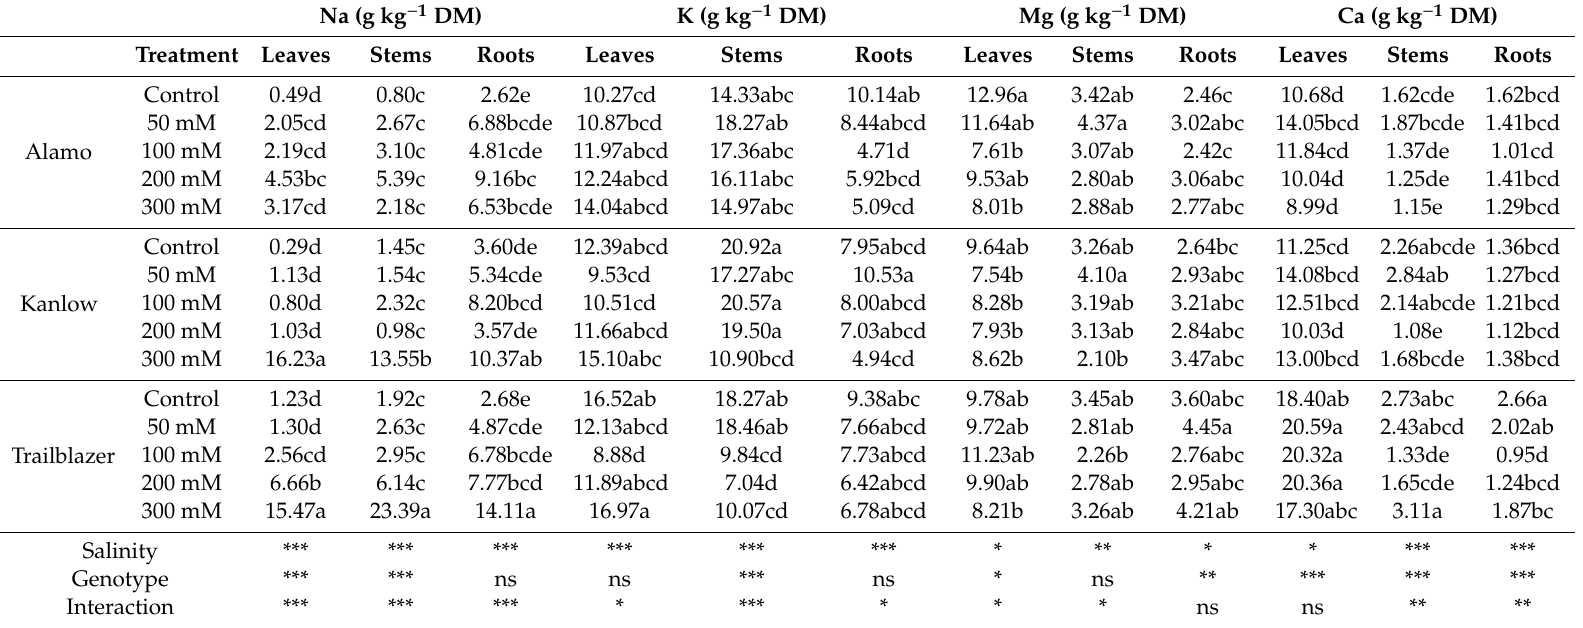
Table 6. The sodium (Na), potassium (K), magnesium (Mg) and calcium (Ca) concentration in the leaves, stems and roots of Alamo, Kanlow and Traiblazer genotypes of Panicum virgatum at 180 DAP and subjected to the control, 50, 100, 200 and 300 mM NaCl